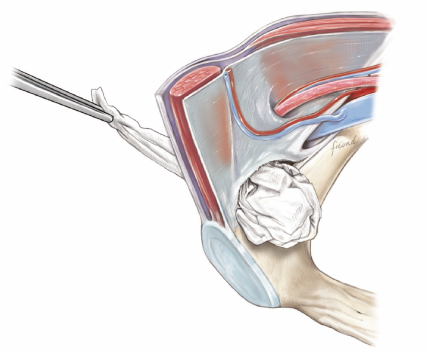
Figure 11: The gauze is